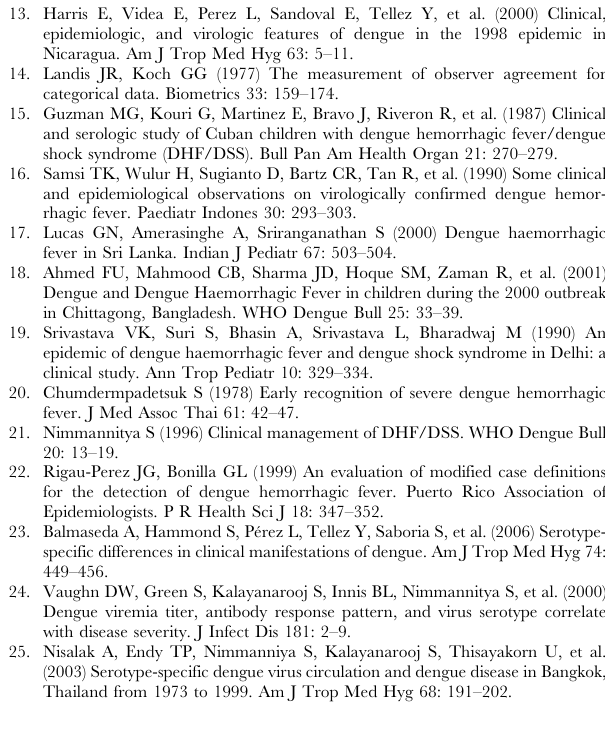
Table S1 Summary of computerized algorithm to